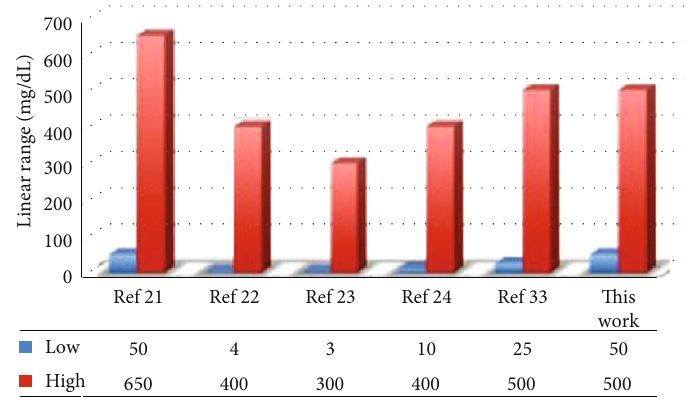
Figure 6: Comparative performance of di ff erent cholesterol biosensors: (a, b) sensitivity, (c) storage stability, and (d) linear range of cholesterol biosensor.